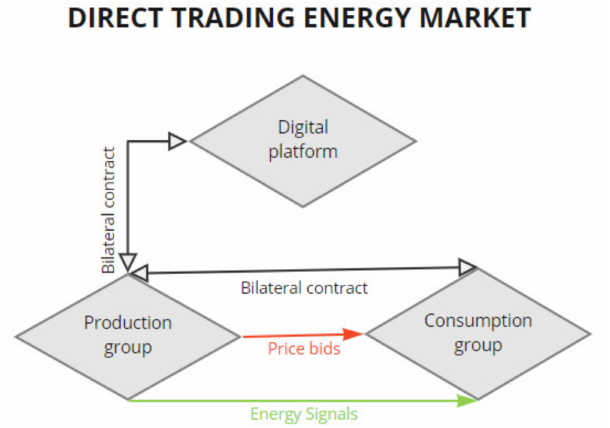
Figure 5. Actors role sketch—direct trading P2P-ET market. Sketch-based on own interpretation from Section